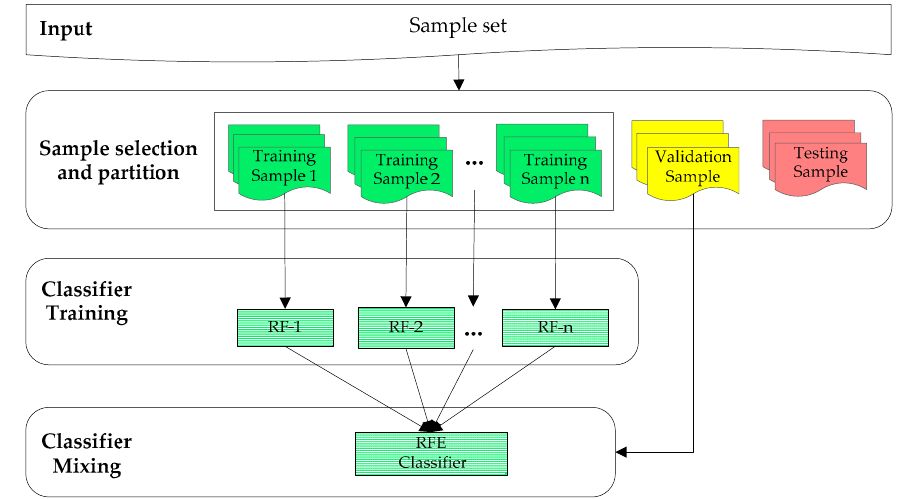
Figure 4. Flowchart for RFE model training.